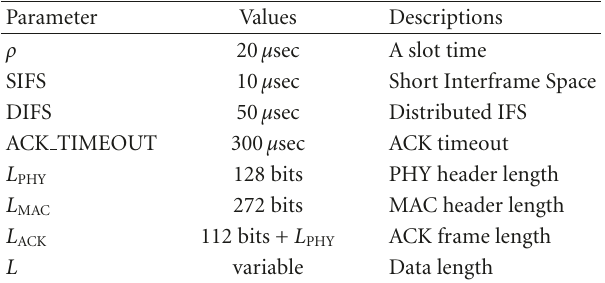
Table 1: Parameter values for the analysis of throughput estima-